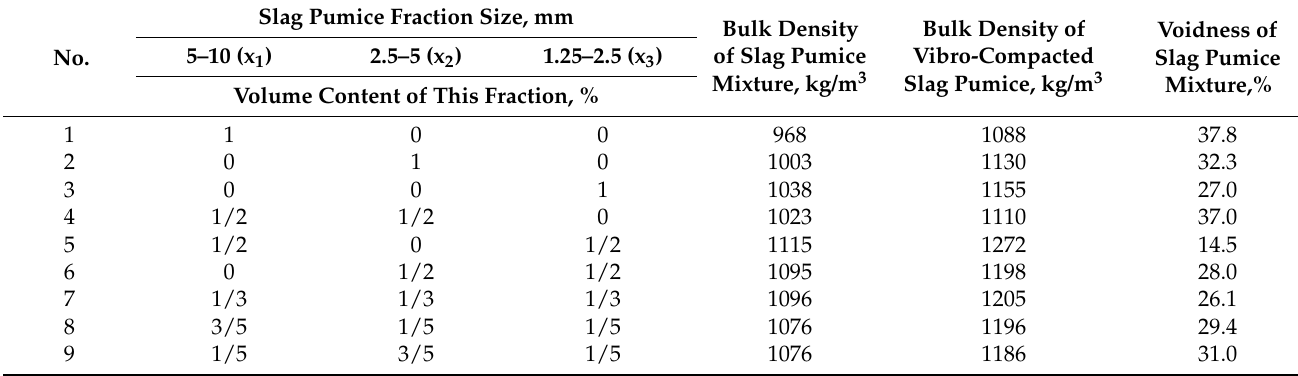
Table 8. Results of the slag pumice experimental